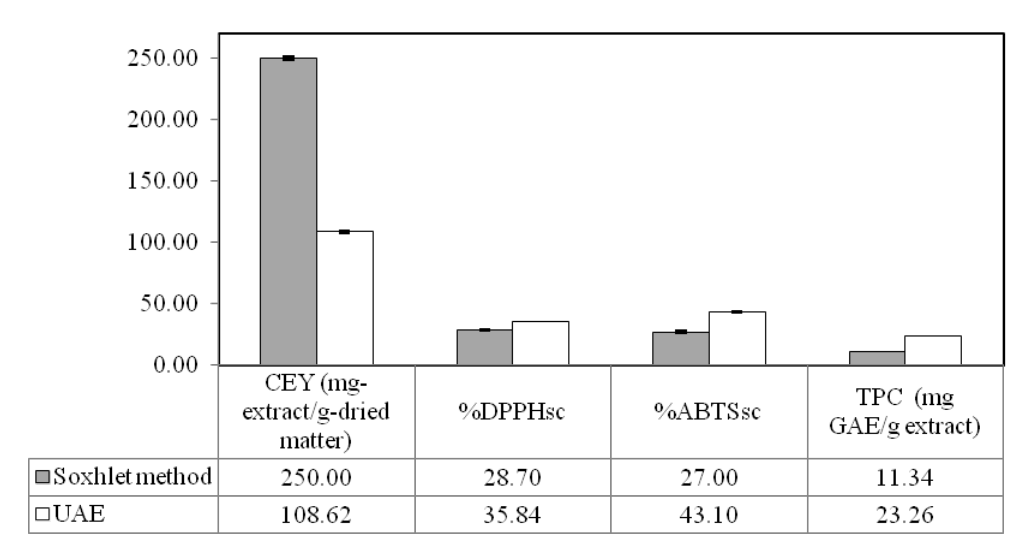
Figure 4. Comparison the quality of extracts obtained by ultrasound-assisted extraction and Soxhlet